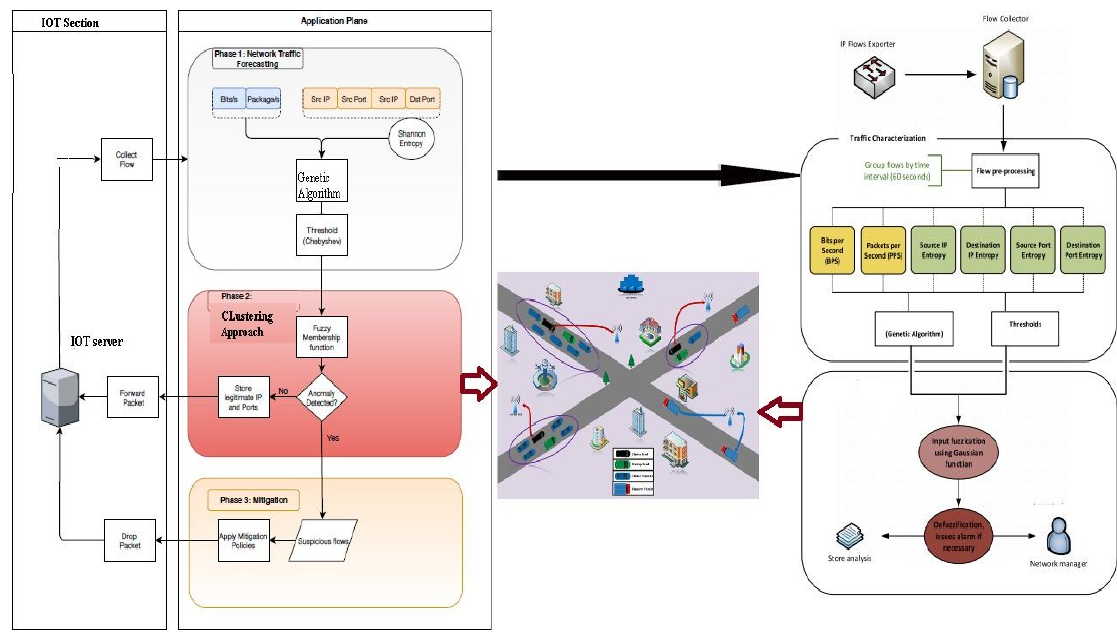
Figure 1. This is a figure. Schemes follow the same